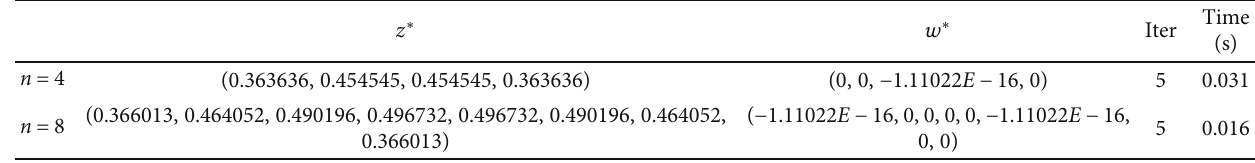
Table 3: Numeric outcomes of the Yu method.